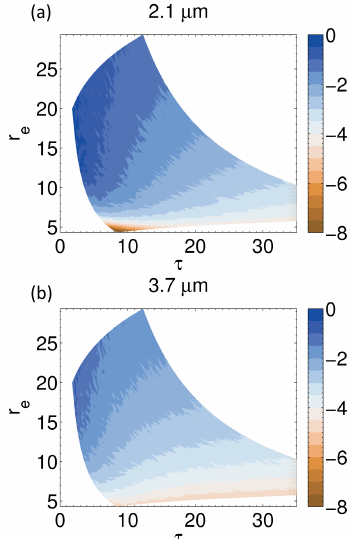
Figure 10. Percentage τ bias (retrieved vs. actual value from the input model profile) as a function of τ and r e